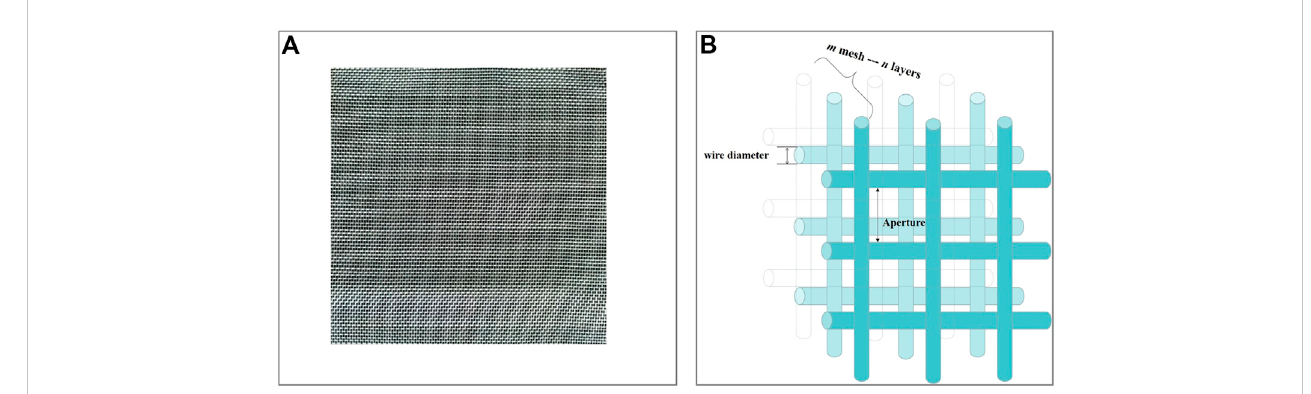
FIGURE 3 Physical and model drawings of wire mesh. (A) Physical image, (B) Model drawing.